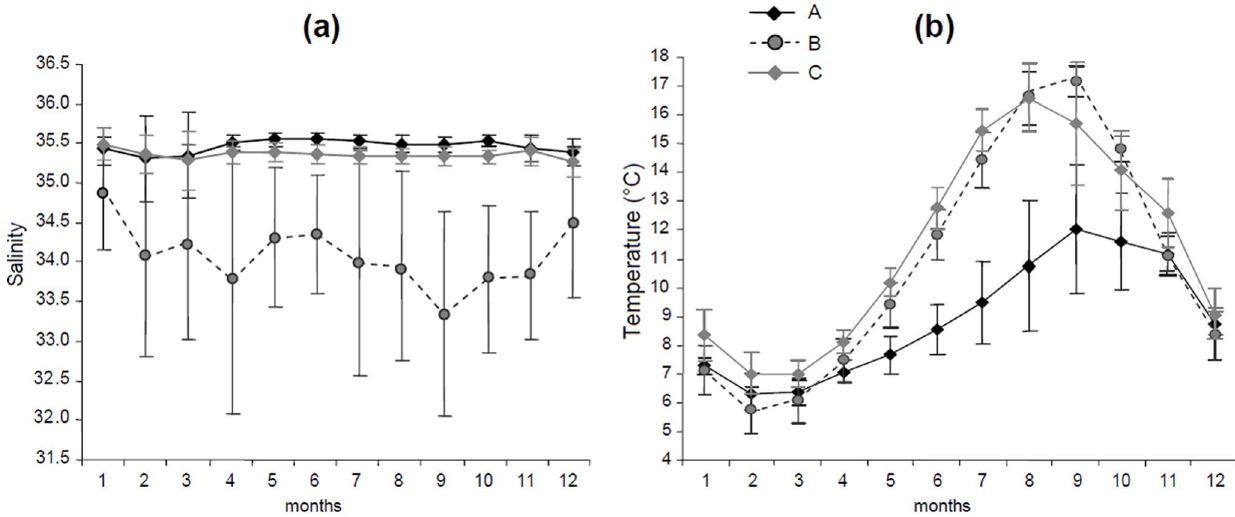
Figure 2. Fish environmental experience. Annual cycle of mean ( 6 SD) salinities (a) and temperatures (b) predicted for the 3 plaice sub-stocks (A, B and C) in the North Sea, based on all the individual locations observed for each month and corresponding environmental conditions derived from the General Estuarine Transport Model for the period 1997–99.